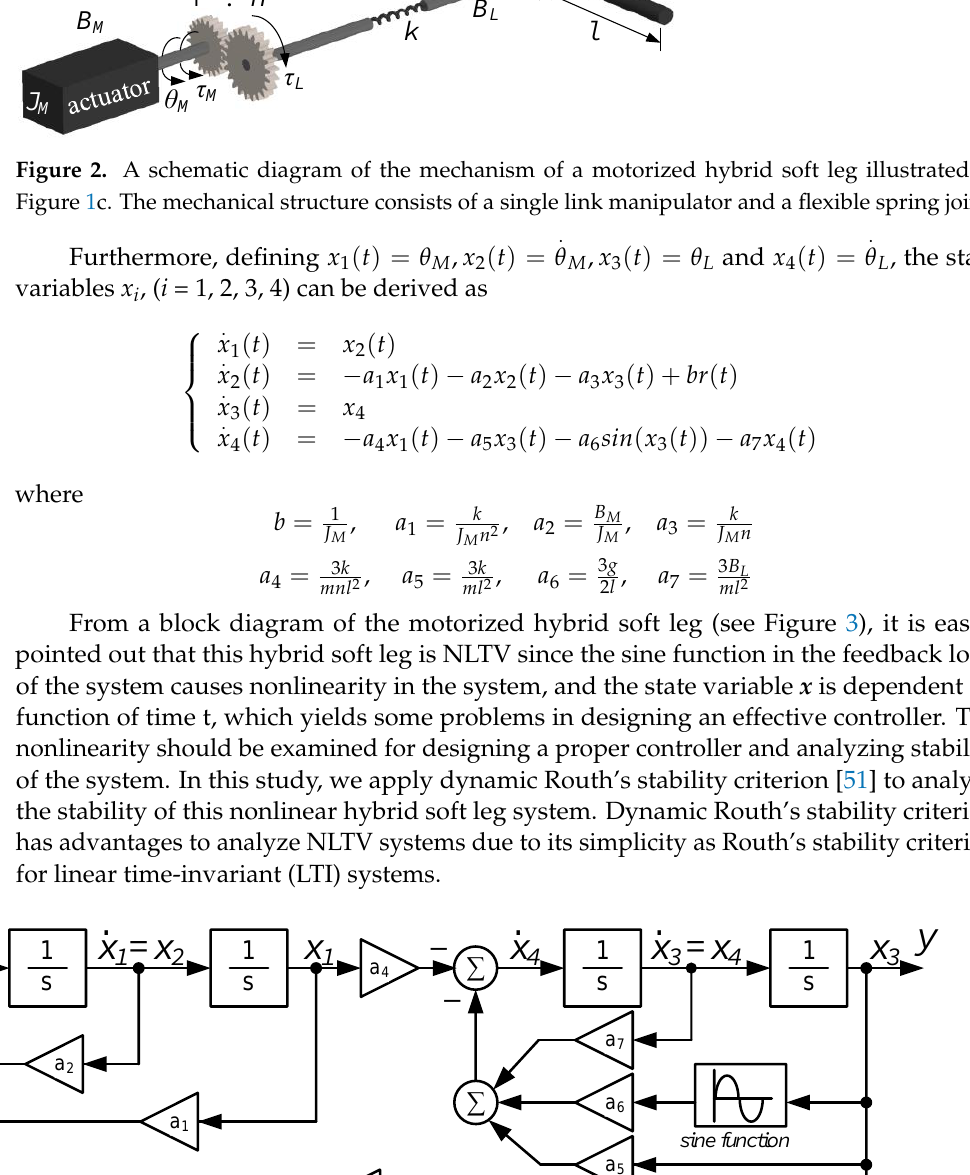
two-dimensional s -plane (i.e., real axis σ and imaginary axis j ω ) to a three-dimensional g -plane (i.e., real axis σ , imaginary axis j ω , and time-dependent variable) as illustrated in Figure 4. The stability region in the g -plane is defined from the definition of stability region in the s -plane (see Figure